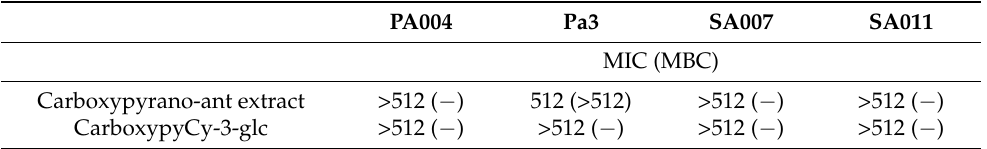
Table 1. Minimum inhibitory concentration (MIC) and minimum bactericidal concentration (MBC) values ( µ g/mL) of carboxypyrano-ant extract and carboxypyCy-3-glc against PA004, Pa3, SA007 and